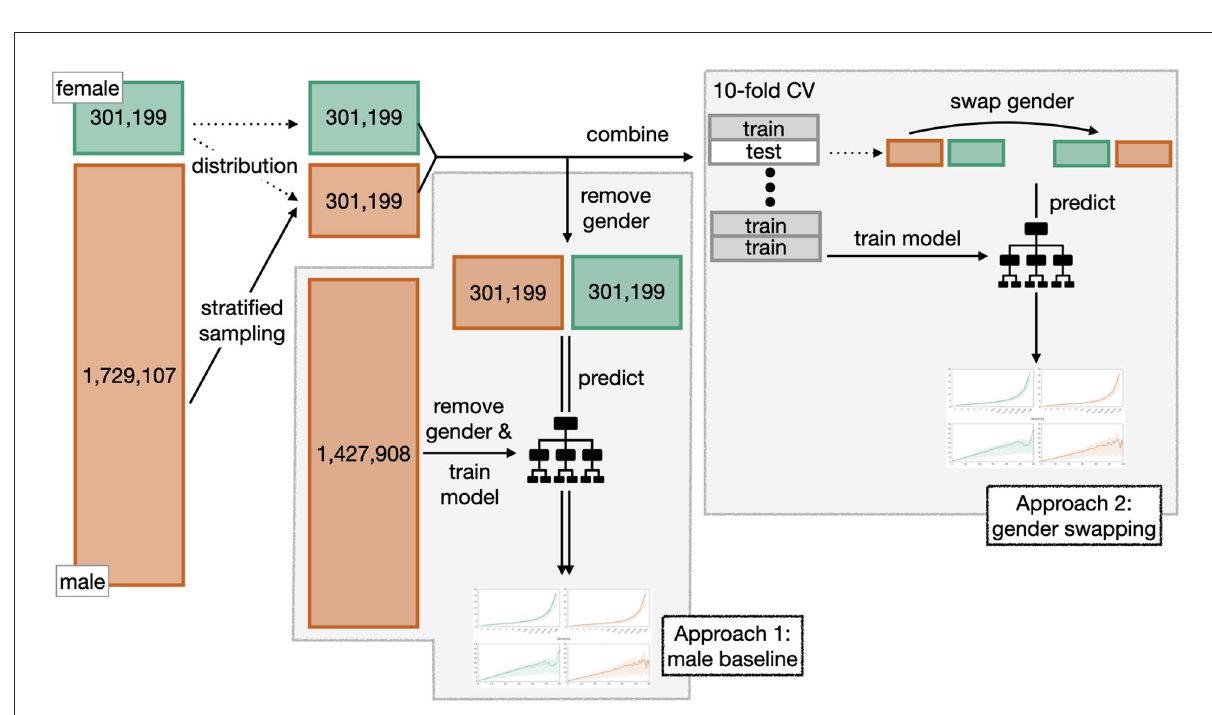
such as gender and race on the likelihood to get invited for an interview. For each target variable, we train a prediction model using data from both women and men, including gender as one of the features. We make sure that the two datasets are